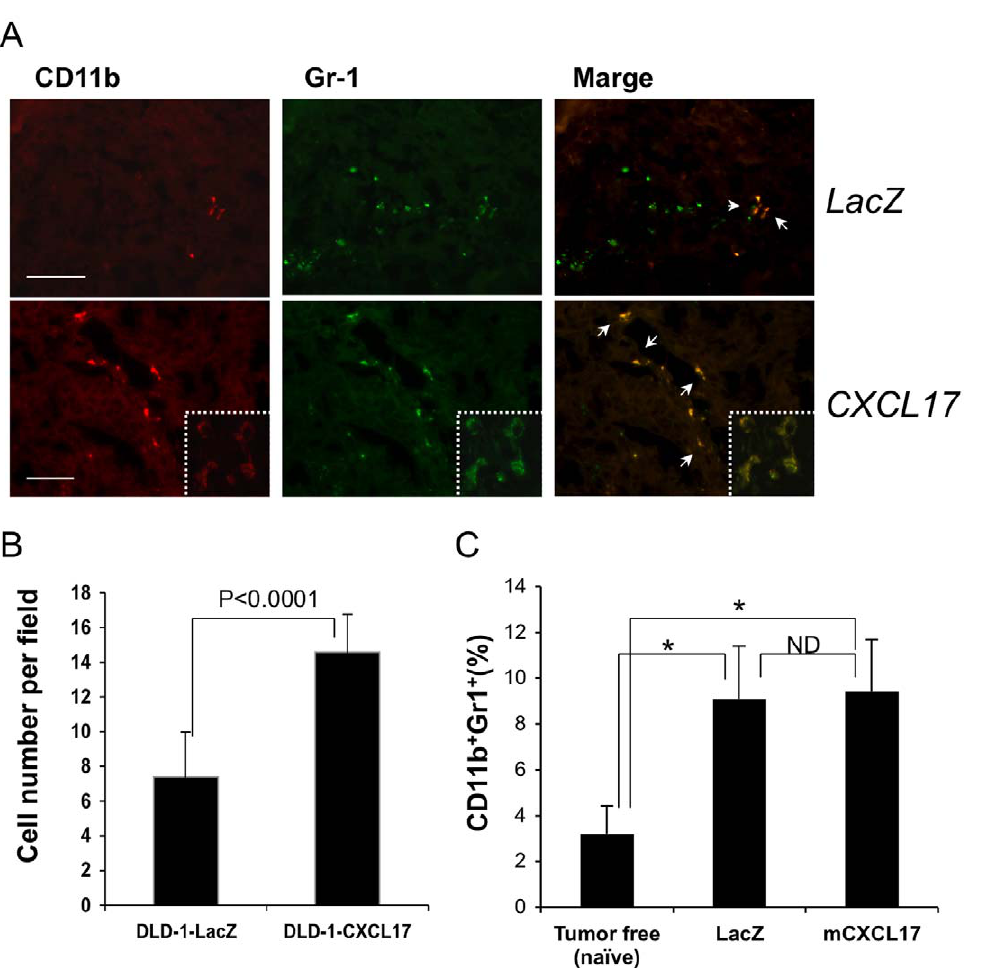
Figure 5. Accumulation of immature myeloid-derived cells in CXCL17-expressing tumor. (A) Tumor sections were stained with anti- CD11b (red) and anti-Gr-1 (green) mAbs. Representative stained images are shown. Upper panels, LacZ transduction; lower panels, CXCL17 transduction. Arrows indicate CD11b + Gr-1 + cells. Higher magnification images are shown in the lower-right corner (white dotted area). Scale bar: 100 um. (B) The number of CD11b + Gr-1 + cells per field. CD11b + Gr-1 + cells were counted in five random sections. One of three independent experiments with similar results is shown. (C) The number of CD11b + Gr-1 + cells was determined by FACS in the spleen of Colon26 tumor-bearing BALB/c mice. *, P , 0.05 (tumor-bearing versus tumor-free naı¨ve mice); ND, not